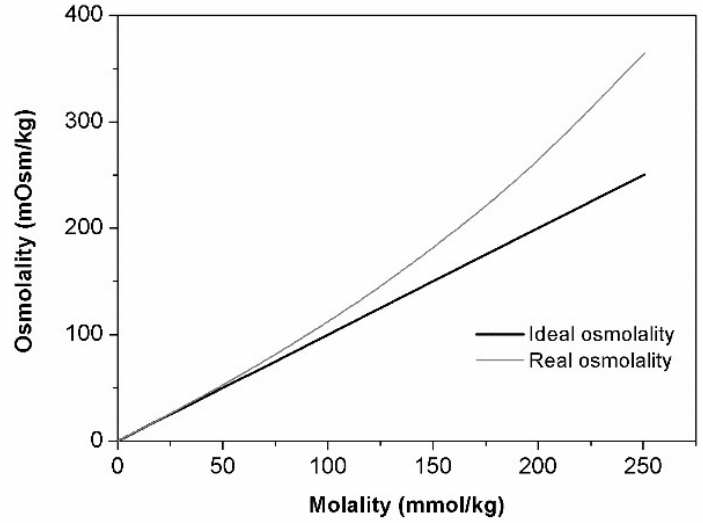
Figure 1. Concentration dependencies of osmolality for HPβCD.